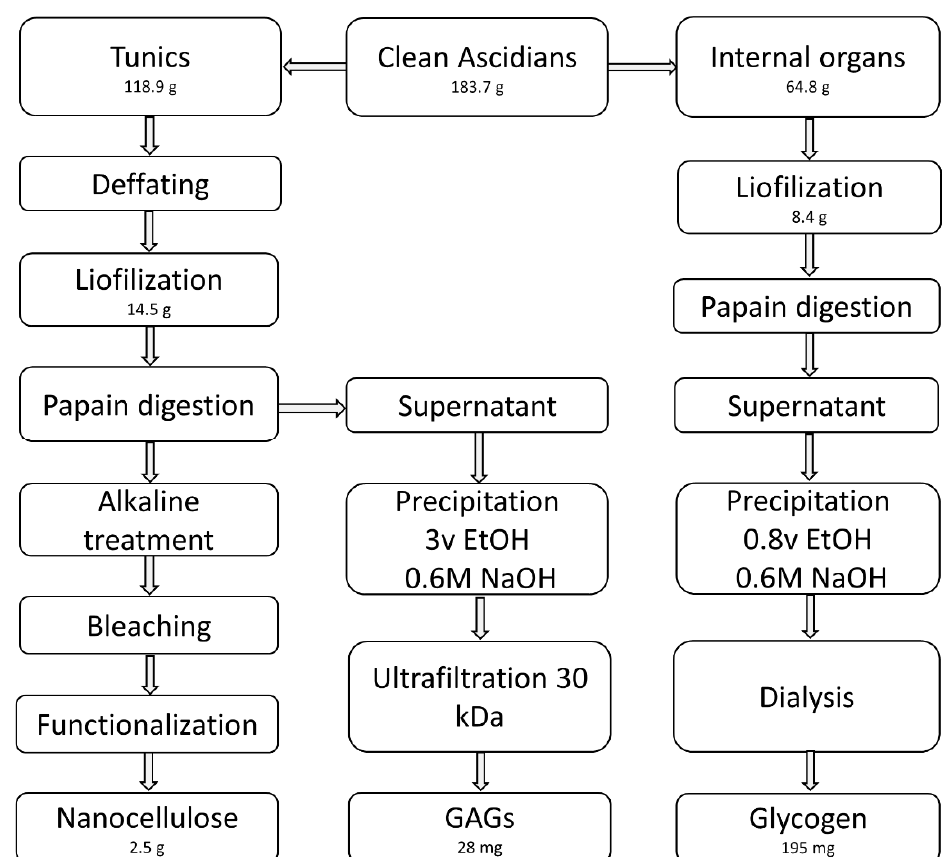
Figure 1. Flowchart for the isolation of polysaccharides and nanocellulose from Styela clava